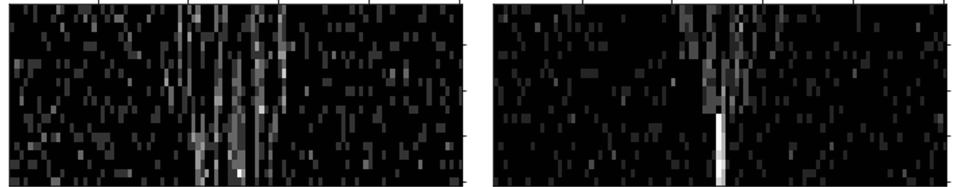
Figure 7. A normal ( left ) and an anomalous ( right ) event used for quantum anomaly detection applied to long-lived particles detection. Normal and anomalous data are, respectively, prompt and displaced decays in multimuons (from two to ten muons). Hits produced by the muons were reconstructed in a toy simulation of the ATLAS MDT chambers that included a random hit back- ground noise mimicking the expected ATLAS phase-2 noise. Data are represented in the form of 100 × 20 pixels